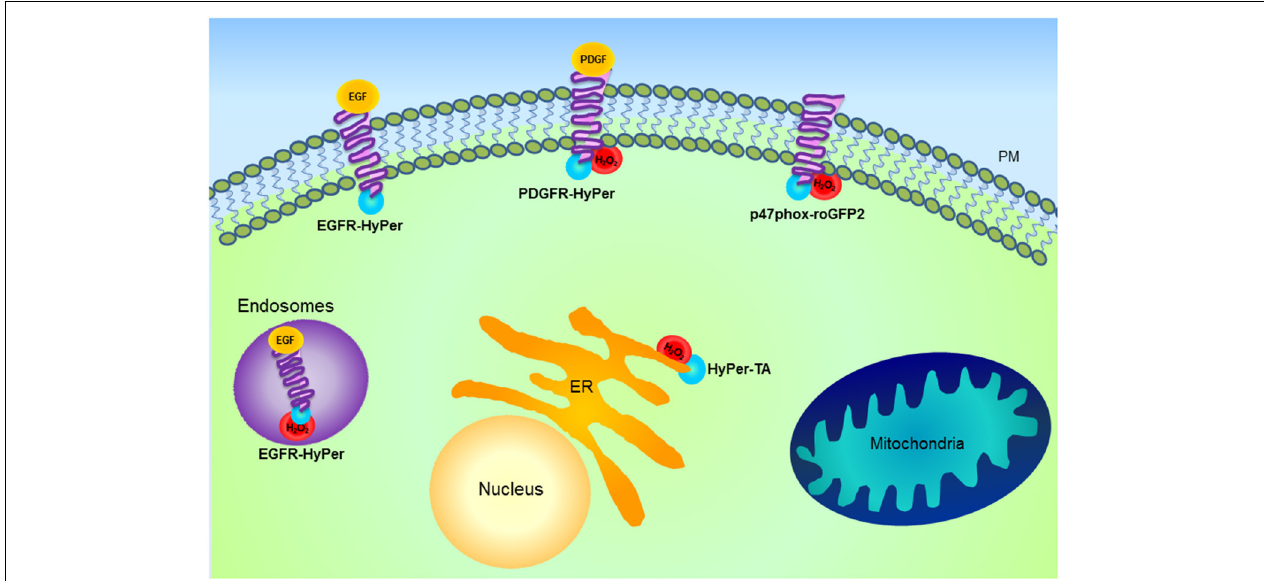
FIGURE 3 | Schematic representation of H 2 O 2 microdomains within different subcellular compartments. Genetically encoded probe HyPer (blue) fused with different proteins including epidermal growth factor receptor (EGFR), platelet-derived growth factor receptor (PDGFR), Nox and tail anchor of protein tyrosine phosphatase 1B (HyPer-TA) is shown. HyPer fusion proteins allow the visualization of focal H 2 O 2 formation. Activation of EGFR is associated with H 2 O 2 microdomains formation (red) on the endosomes, while PDGFR activation generates H 2 O 2 microdomains at the plasma membrane (PM) and only after prolonged incubation on the endosomes. Activation of both receptors results in